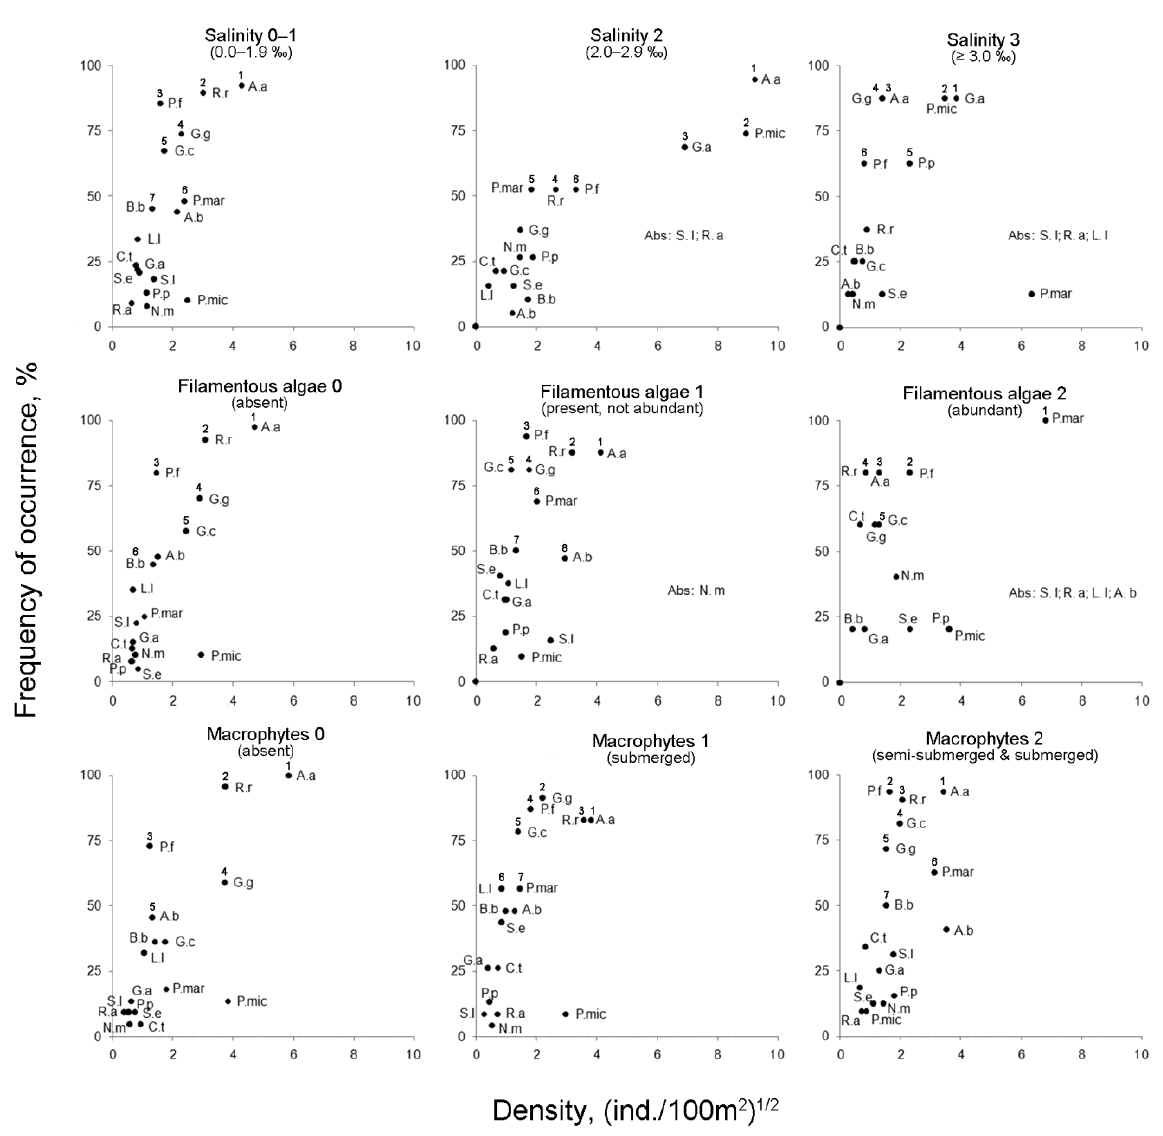
Figure 6. Variability of occurrence and mean density per 100 m 2 of 17 fish species (except for “spo- radic” species; see Table 2) at the different values of three environmental factors.